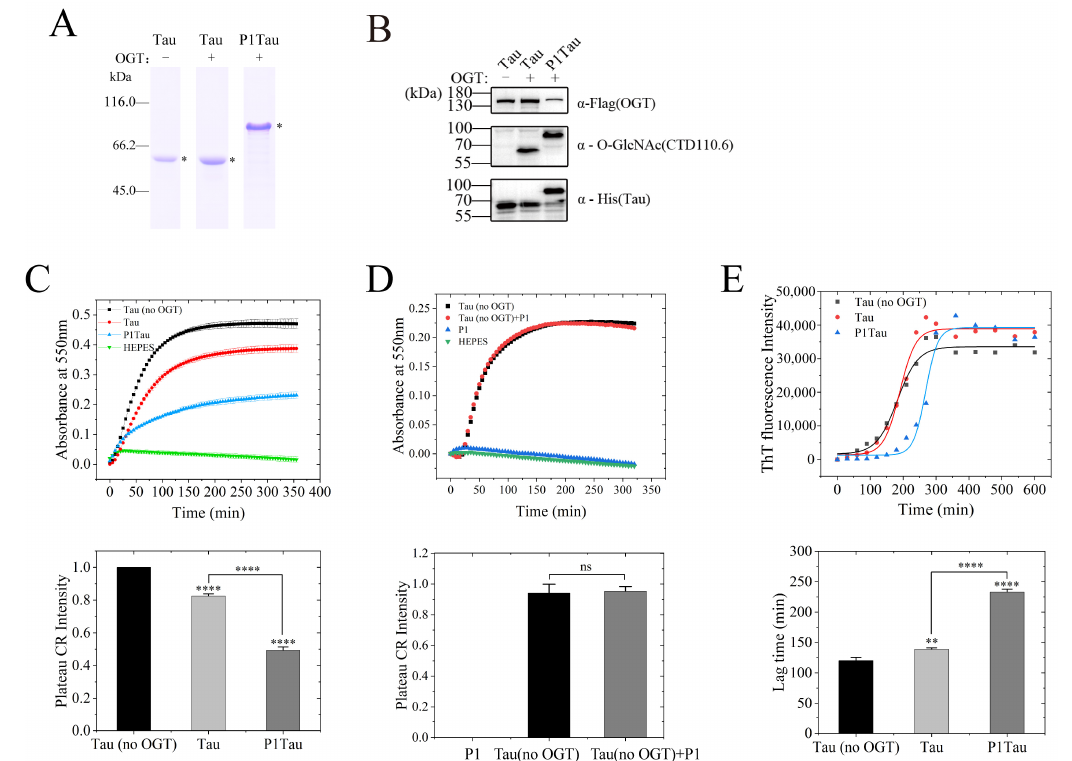
Figure 3. Increased O-GlcNAcylation dramatically decreased the fibrillization of full-length human Tau in vitro. ( A ) Coomassie blue (CB)-stained SDS-PAGE gel of Tau (no OGT), O-GlcNAcylated Tau, and P1Tau proteins were purified using a SP Sepharose column and analyzed using Coomassie brilliant blue staining. ( B ) The expression levels of OGT, Tau (or P1Tau), and O-GlcNAc Tau (or P1Tau) were analyzed using a Western blot with anti-Flag, anti-His, and anti-O-GlcNAc antibody (CTD110.6). ( C ) Samples (10 µ M) of Tau (no OGT, black solid square), Tau (red solid circle), and P1Tau (blue solid triangle) aggregated using 50 µ M Congo red (CR) and detected at 550 nm for 6 h. ( D ) Samples (10 µ M) of Tau (no OGT, black solid square), Tau (no OGT) +P1 (10 µ M) (red solid circle), and P1 (blue solid triangle) aggregated using 50 µ M Congo red (CR) and detected at 550 nm for 6 h. The normalized plateau value of Tau fiber growth curve at the bottom determined a ratio of insoluble Tau aggregate in total Tau and is expressed as the mean ± S.D. ( n = 3 biologic replicates). ( E ) Aggregation of 10 µ M proteins in the presence of 2.5 µ M heparin was detected using ThT fluorescence at 480 nm for 10 h. The lag times of fibril formation of Tau (no OGT), O-GlcNAcylated Tau, and P1Tau were determined using a sigmoidal equation using the data. The ThT fluorescence intensity and lag time are expressed as the mean ± S.D. ( n = 3 biologic replicates). Statistical analyses were performed